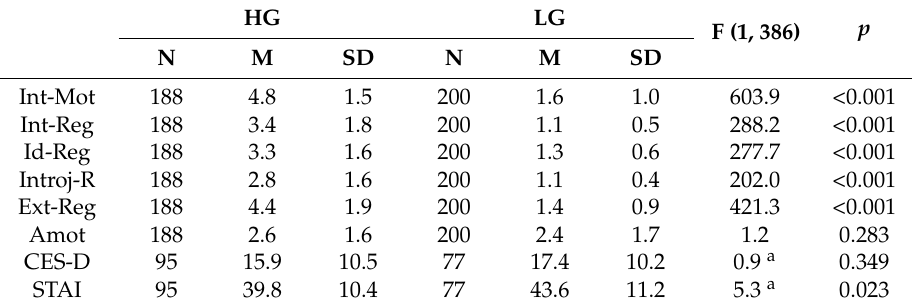
Table 3. Descriptive statistics (M, SD) comparing Heavy Gamers (HG) and Light Gamers (LG) on each of the six GAMS-it factors and for CESD and STAI